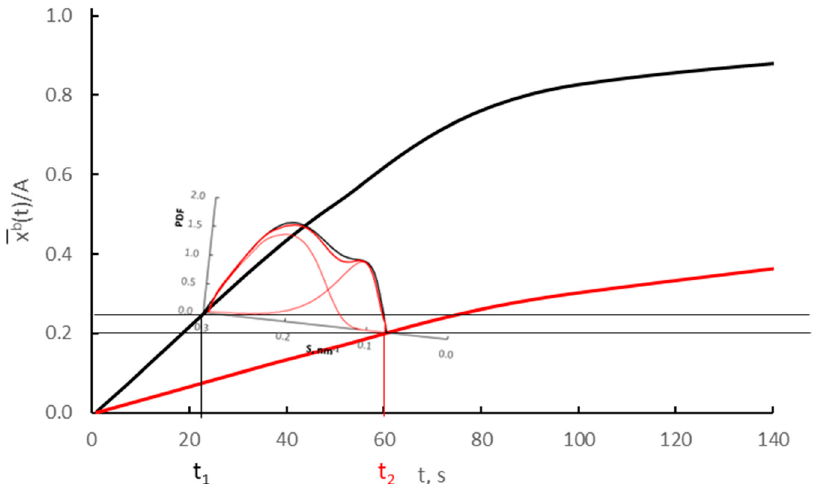
Figure 3. Change in the average concentration of nitrogen in the volume of iron nanocrystallites with an active specific surface area 0.15 nm − 1 (black color) and 0.04 nm − 1 (red color) as x b ( t ) /A = f(t) with a diffusion coefficient D = 0.1 nm 2 /s.